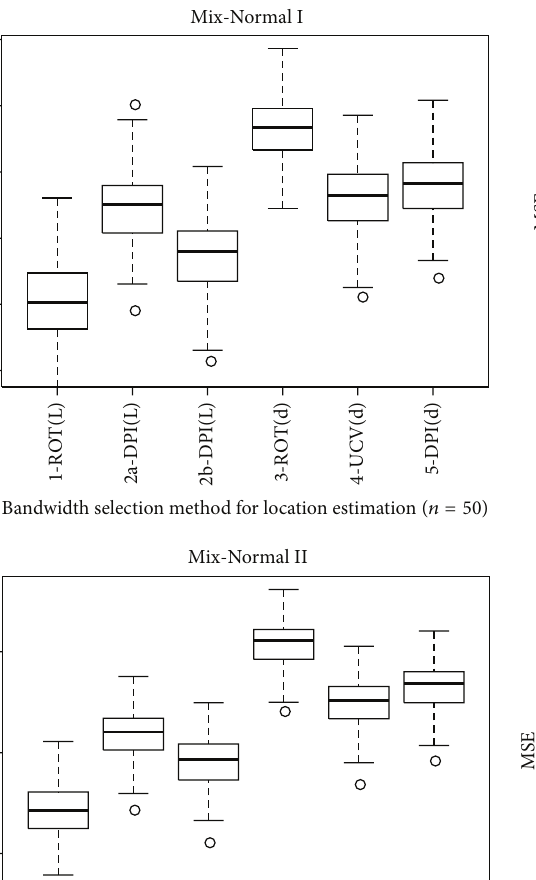
ℎ ; “1-ROT(L)” means ̂ℎ ; “3-ROT(d)” means LSCV ; density